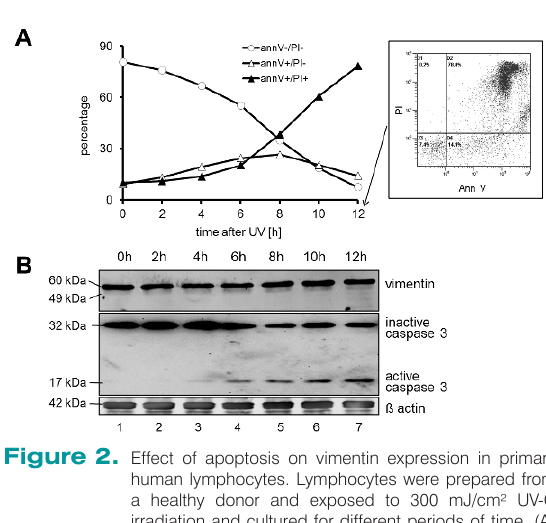
Figure 2. Effect of apoptosis on vimentin expression in primary human lymphocytes. Lymphocytes were prepared from a healthy donor and exposed to 300 mJ/cm² UV-C irradiation and cultured for different periods of time. (A) cells were analysed at the indicated points in time for binding of annexin V (ann V) and propidium iodide (PI). The insert on the right side exemplifies the results of such an analysis. (B) Western blot analysis of cells harvested at the indicated time after